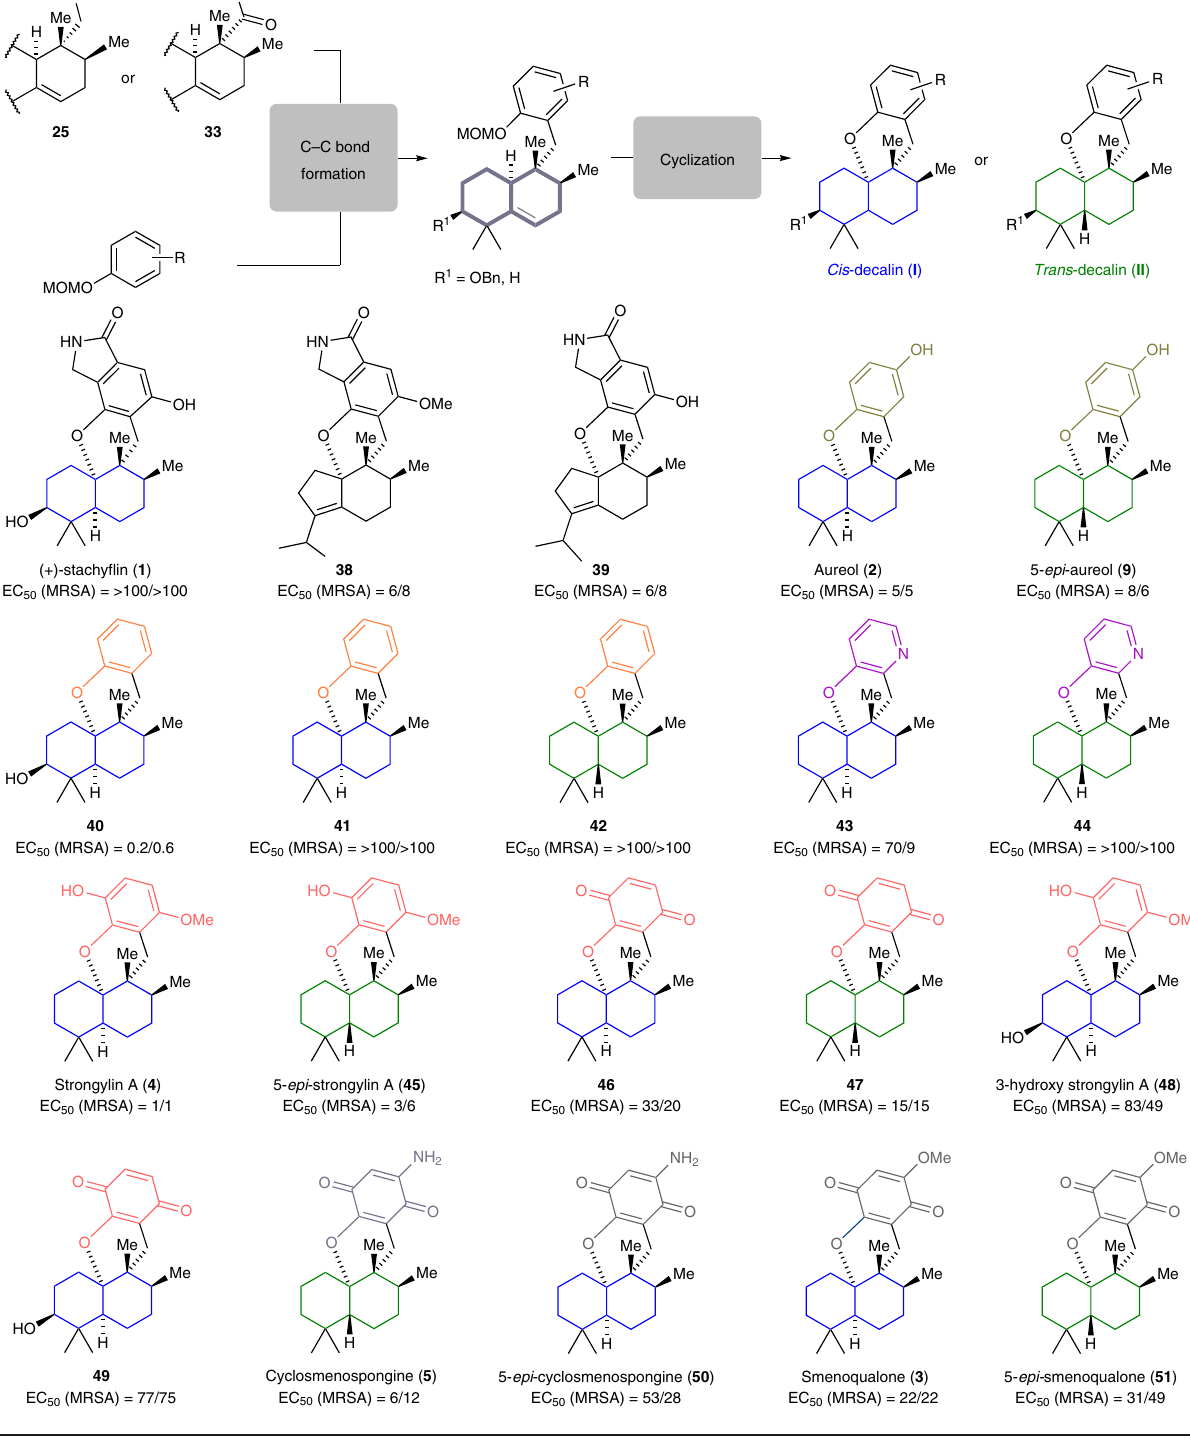
50 values) that inhibited the growth of